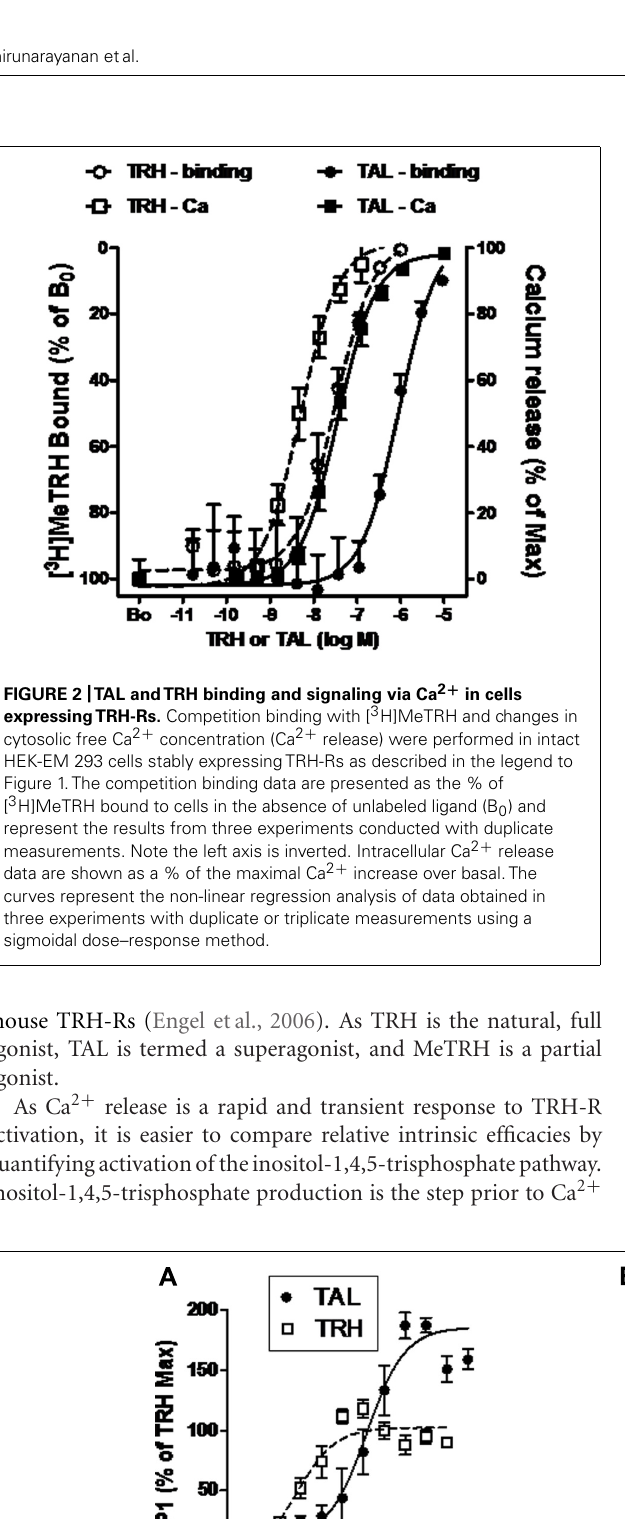
(B) MeTRH inhibits IP1 formation stimulated byTAL andTRH. IP1 production was determined in the presence ofTRH (0.1 μ M),TAL (3 μ M), MeTRH (3 μ M),TRH + MeTRH, orTAL + MeTRH.The data are expressed as mean ± SEM performed in duplicate of two